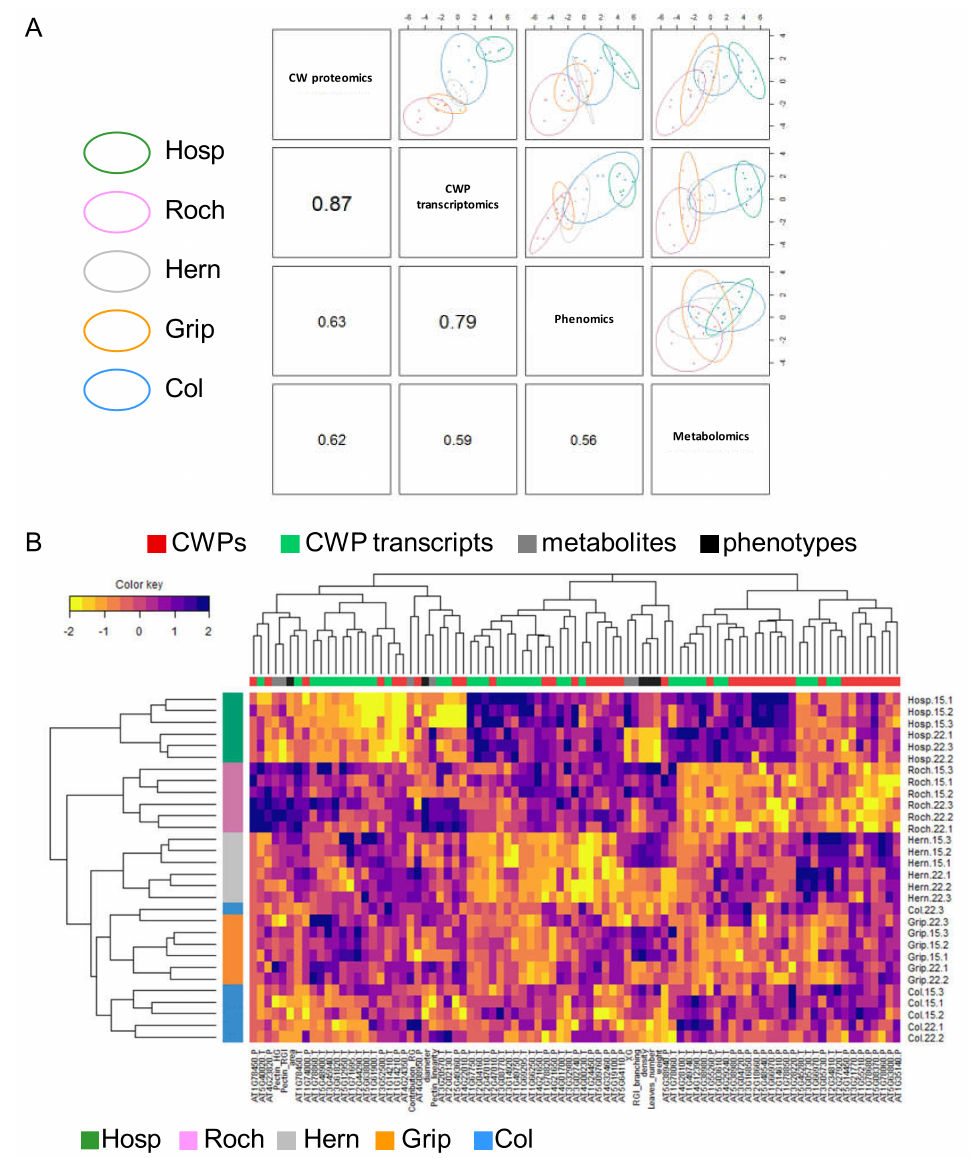
Figure 7. Graphical representation of sparse MB-PLS-DA analyses that discriminate the rosette samples according to Col, Roch, Grip, Hern and Hosp. ( A ) The plotDIABLO shows the correlation inside each block pairs; ( B ) clustered image map representing the multi-omics profiles for each sample discriminated according to populations and Col. The levels of yellow (lower values) and purple (higher values) denote scaled values for each variable. Note that colors are scaled per